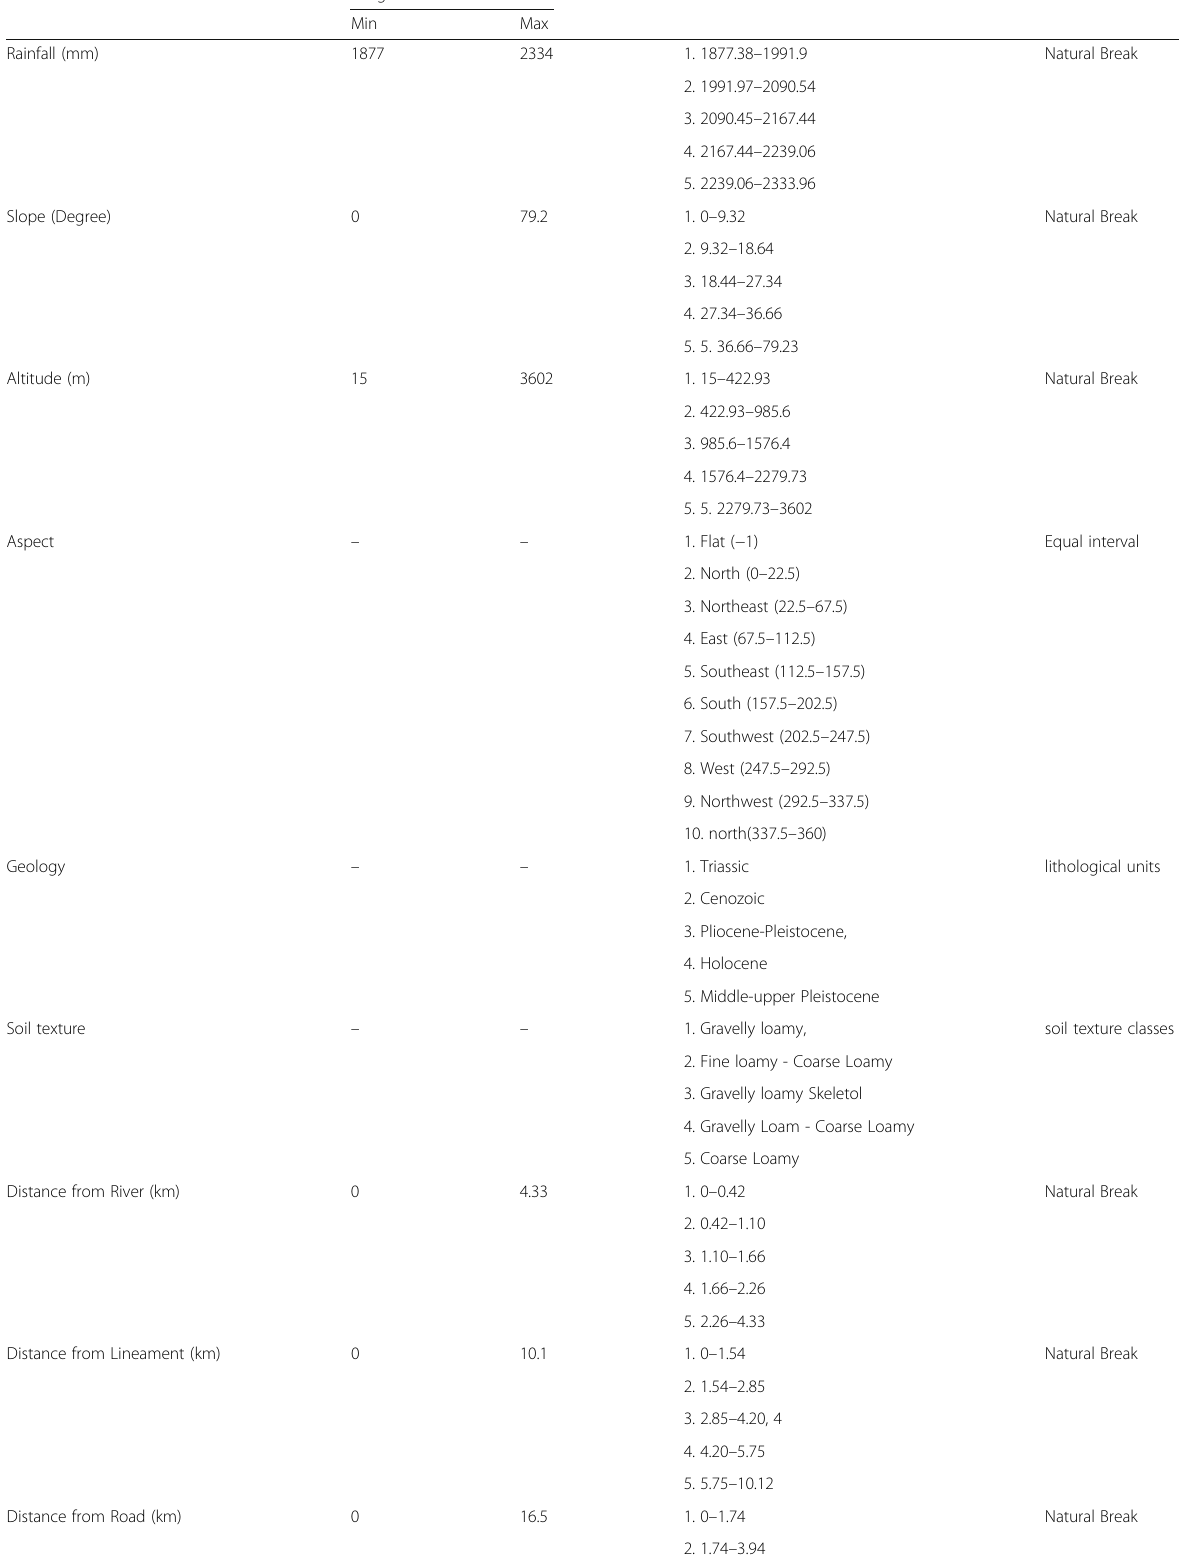
Table 2 Overview of selected parameters used for landslide susceptibility mapping Parameters